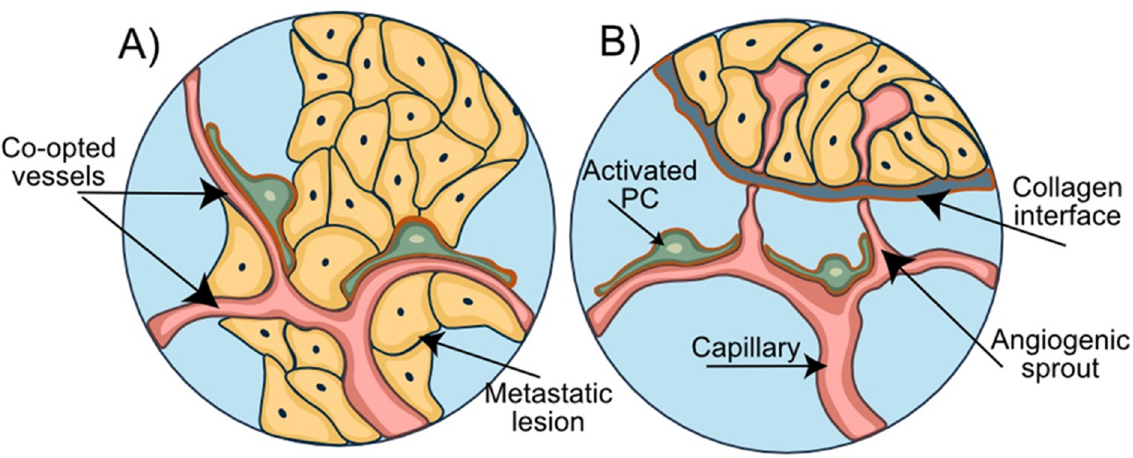
Figure 5. Invasion patterns of breast-to-brain metastasis. ( A ) Breast-to-brain metastases are of the papillary type and characterized by the abundant vessel co-option and close direct contacts between the breast cancer cells, blood vessels, and pericytes. ( B ) Brain metastases of the pushing type, originating, for example, from colon cancer, show a distinct collagen layer separating the metastatic lesion from the capillaries and surrounding pericytes.